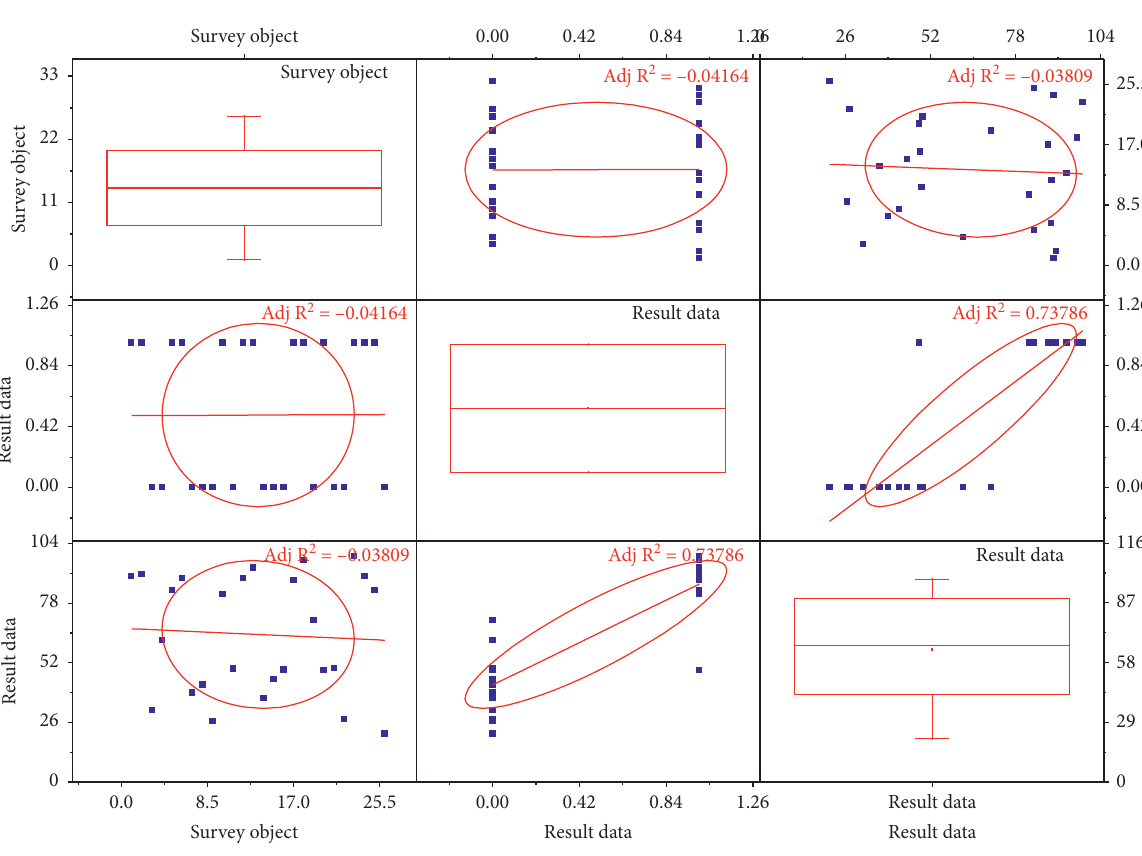
Figure 9: Fraud likelihood